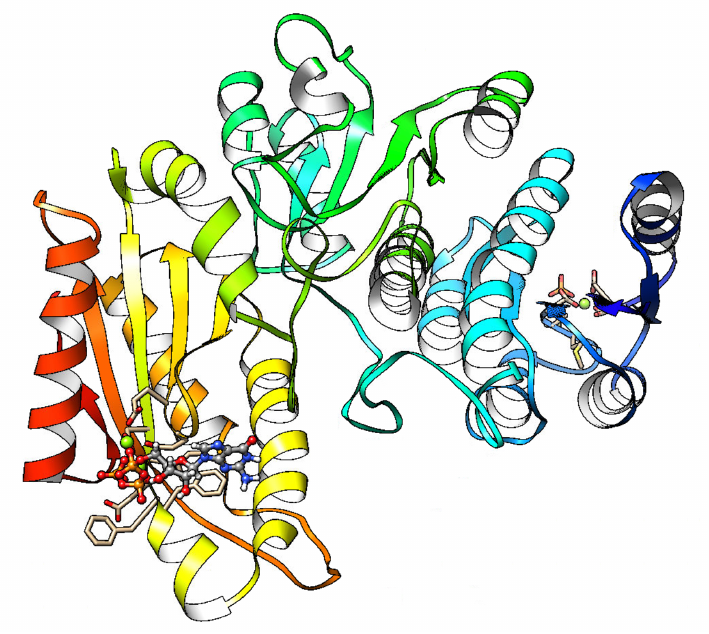
Figure 2. Average structure of PleD protein obtained from 20 ns of MD simulation. GTP, ASP52-phosphate moiety, and Mg 2 + ions are presented in ball and stick representation. ICM scores for the best 100 hits molecules are summarized in Table S1 in Supplementary Materials. They have ICM score energies ranging from − 47.13 to − 31.62 kcal/mol. Based on results from